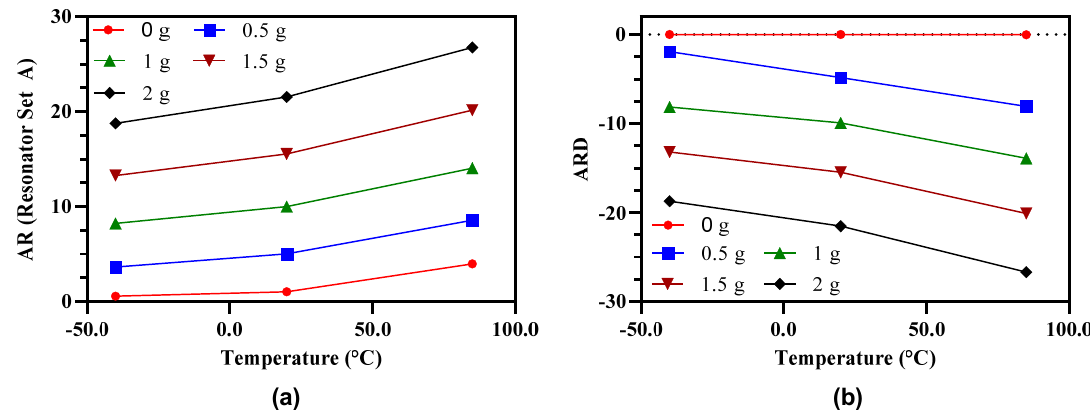
Figure 21. Effect of operating temperature variations on the ( a ) Amplitude ratio and ( b ) amplitude ratio difference of the MEMS accelerometer.